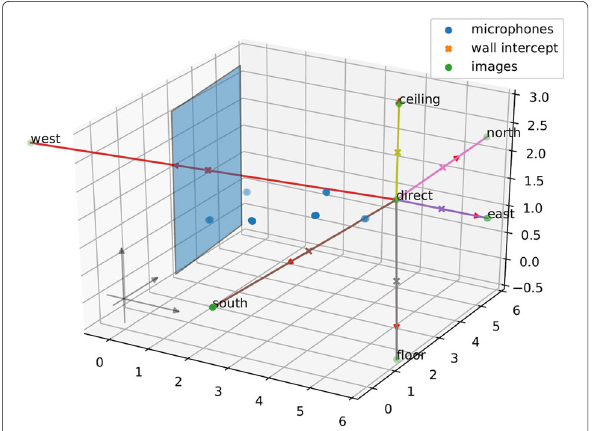
Fig. 8 Image source estimation and reflector estimation for one of the sound sources in the